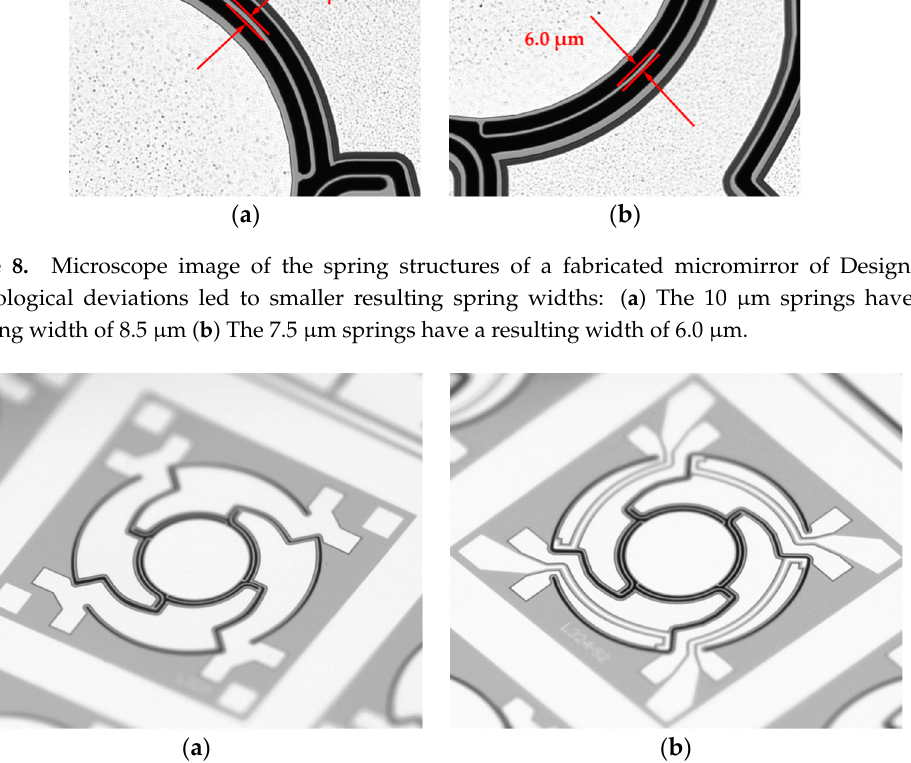
Figure 9. Photography of the processed micromirror devices on wafer level captured by a stereo microscope: ( a ) Design 2; ( b ) Design 1-S.